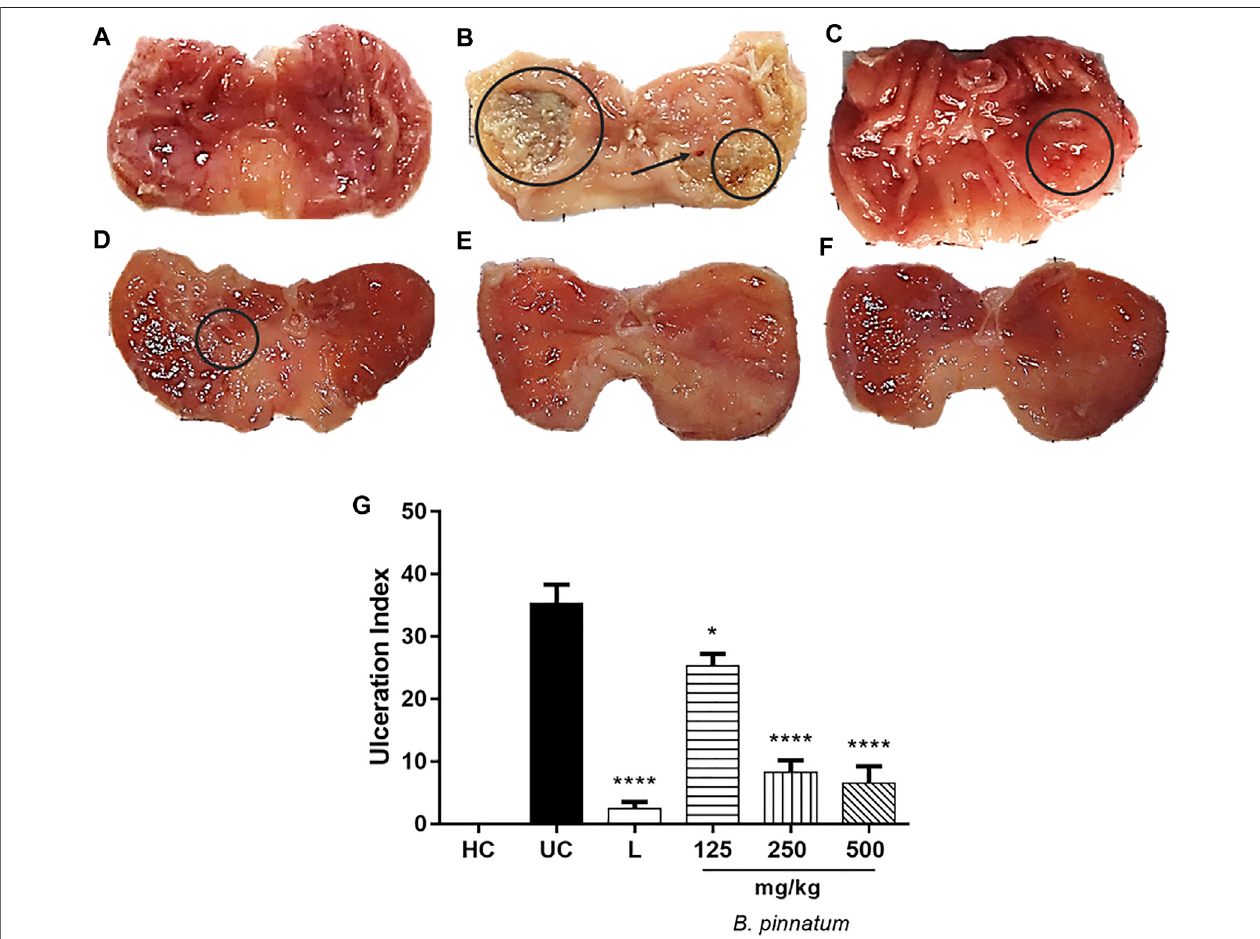
FIGURE 3 | Effect of treatment with B. pinnatum leaf extract (125, 250, and 500 mg/kg) on the acetic acid – induced chronic gastric ulcer model in rats (A) healthy; (B) gastric lesion control; (C) lansoprazole 30 mg/kg; (D) B. pinnatum 125 mg/kg; (E) B. pinnatum 250 mg/kg; (F) B. pinnatum 500 mg/kg. (G) Results expressed as mean ± standard mean error ( n (cid:2) 6). ANOVA and Dunnett post-test were used to calculate the statistical signi fi cance, * p < 0.05, ** p < 0.01, and **** p < 0.0001 vs. ulcerated control. Healthy control, HC; ulcerated control, UC; lansoprazole (30 mg/kg), L.